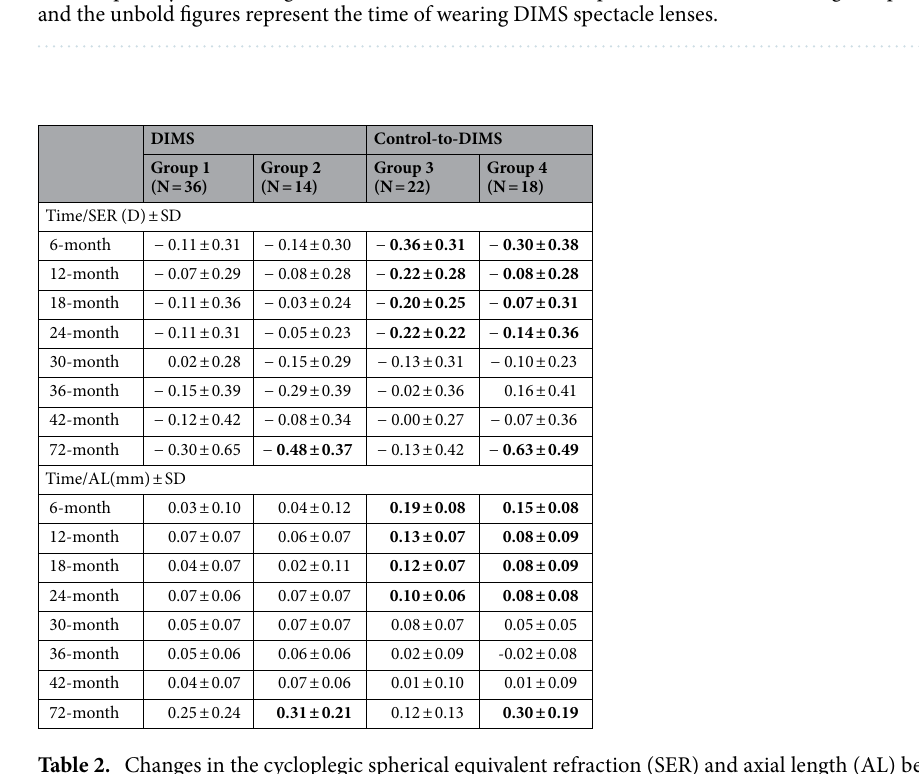
Table 2. Changes in the cycloplegic spherical equivalent refraction (SER) and axial length (AL) between different visits in Groups 1–4. SER: spherical equivalent refraction, D = dioptres, AL: axial length. The bold figures represent the time of wearing SV spectacle lenses and the unbold figures represent the time of wearing DIMS spectacle lenses.